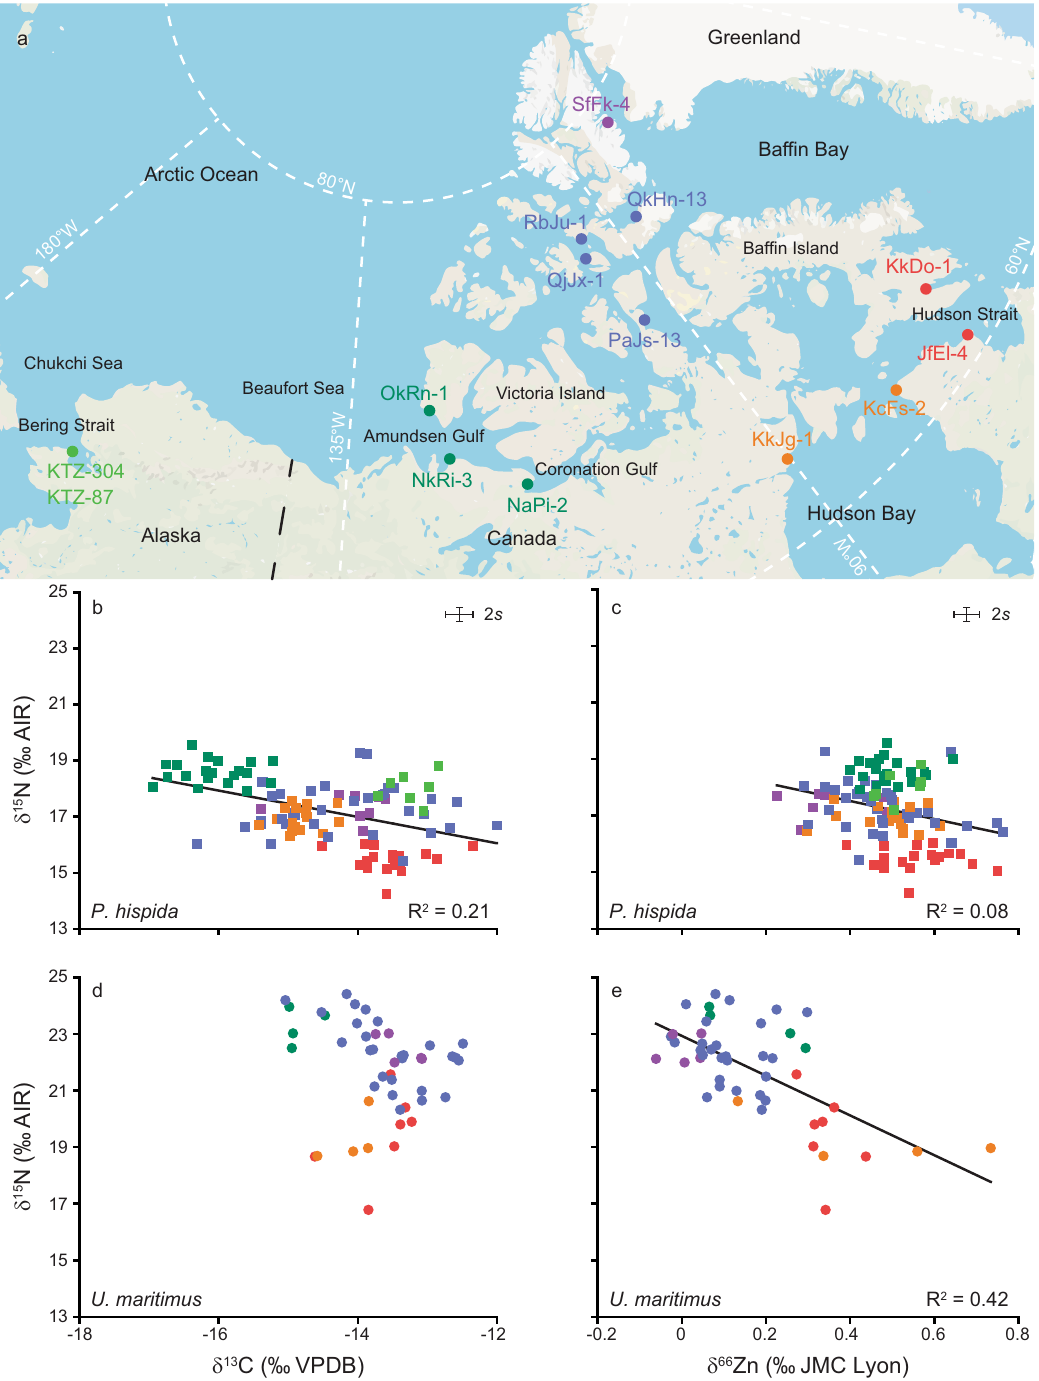
Fig. 1 Isotopic composition of P. hispida and U. maritimus bone samples from Arctic archaeological sites. Pusa hispida (squares, n = 104) and U. maritimus (dots, n = 47) bone samples are colour coded as geographic groups. a Schematic map indicating the archaeological sites analysed and geographic colour coding: Light green for the Bering Strait; dark green for the Amundsen and Coronation Gulf; blue for the CAA; orange for the Hudson Bay; purple for the North Water Polynya; and red for sites in fl uenced by the Labrador Sea in the Hudson Strait and Frobisher Bay. b δ 15 N versus δ 13 C plot for P. hispida samples ( p- value < 0.05; R 2 = 0.21; n = 104). c ) δ 15 N versus δ 66 Zn plot for P. hispida samples ( p- value < 0.05; R 2 = 0.08; n = 104). d δ 15 N versus δ 13 C plot for U. maritimus samples (no correlation, p- value > 0.05; n = 47). e δ 15 N versus δ 66 Zn plot for U. maritimus samples ( p- value < 0.05; R 2 = 0.42; n = 47). We included already published δ 15 N and δ 13 C values 4,15,30,31 and already published δ 66 Zn values from QjJx-1 15 . The map is redrawn and modi fi ed using Adobe Illustrator CS6 after www.google.com/maps. Error bars represent the measurement